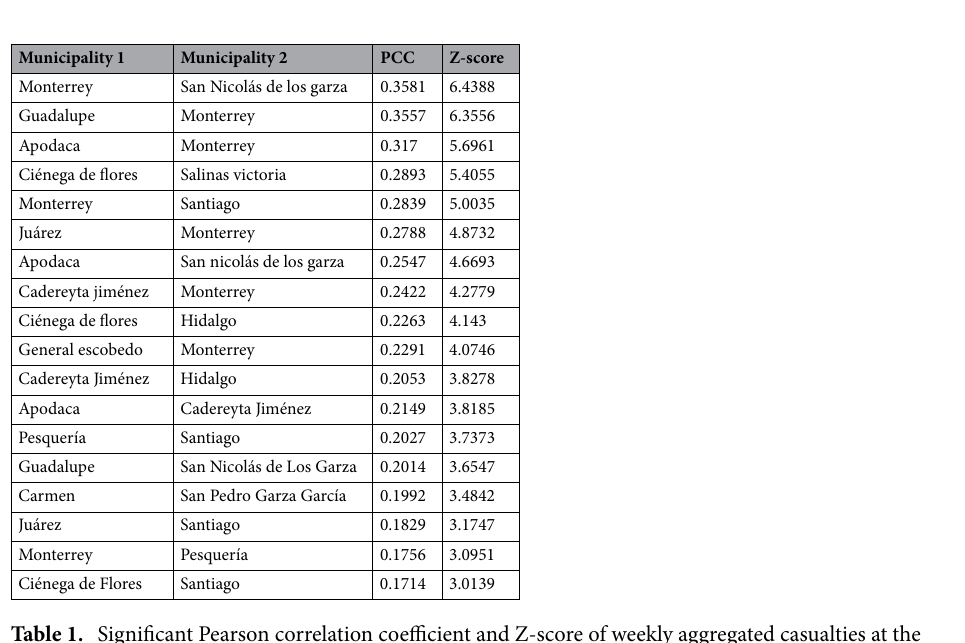
Table 1. Significant Pearson correlation coefficient and Z-score of weekly aggregated casualties at the municipality